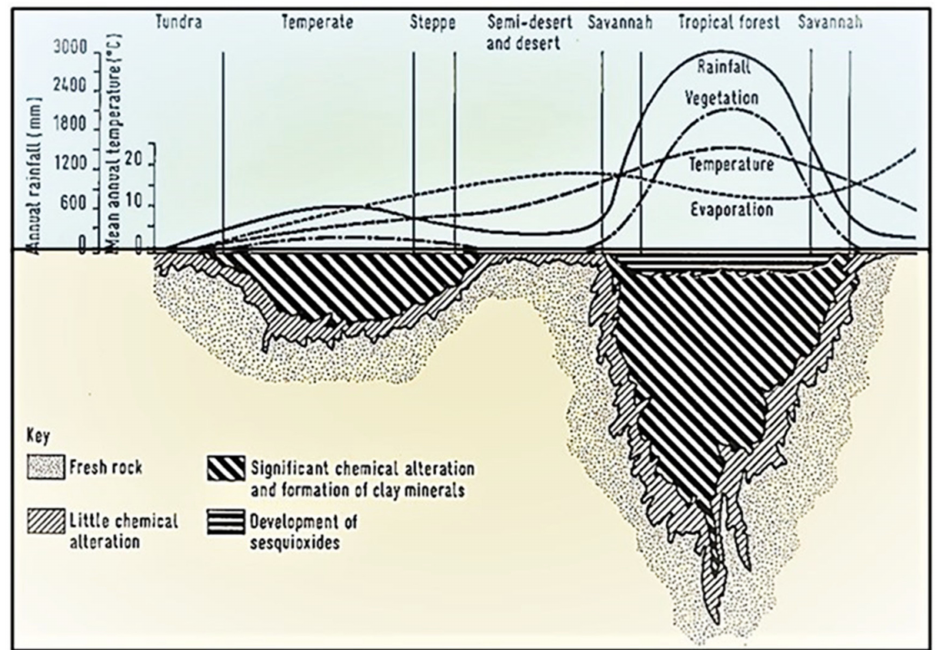
Figure 7. Illustration of the influence of various factors on the extent of chemical weathering of materials on the surface of the Earth (created from [34]).